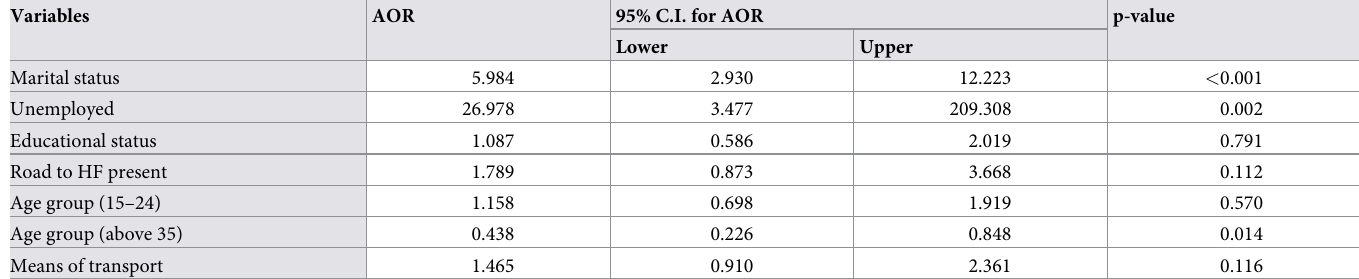
Table 4. Multivariable regression results for factors associated with the second maternal delay among pregnant women in Ilubabor zone, Southwest Ethiopia, Feb- ruary to April 2021 (n = 402).